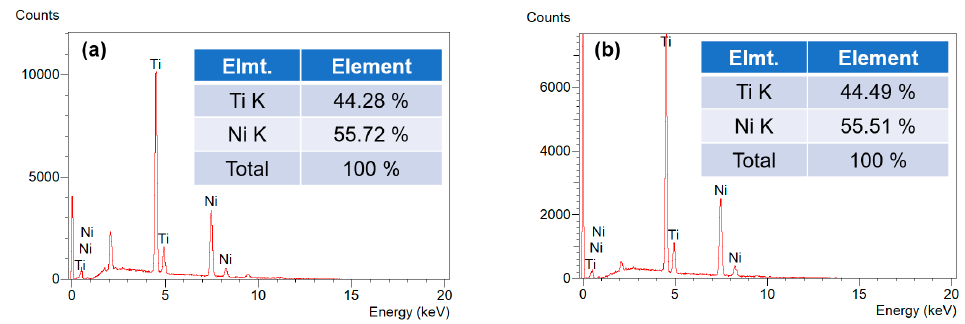
Figure 9. EDS test results of a workpiece’s surface ( a ) before finishing and ( b ) after finishing with grapeseed oil.